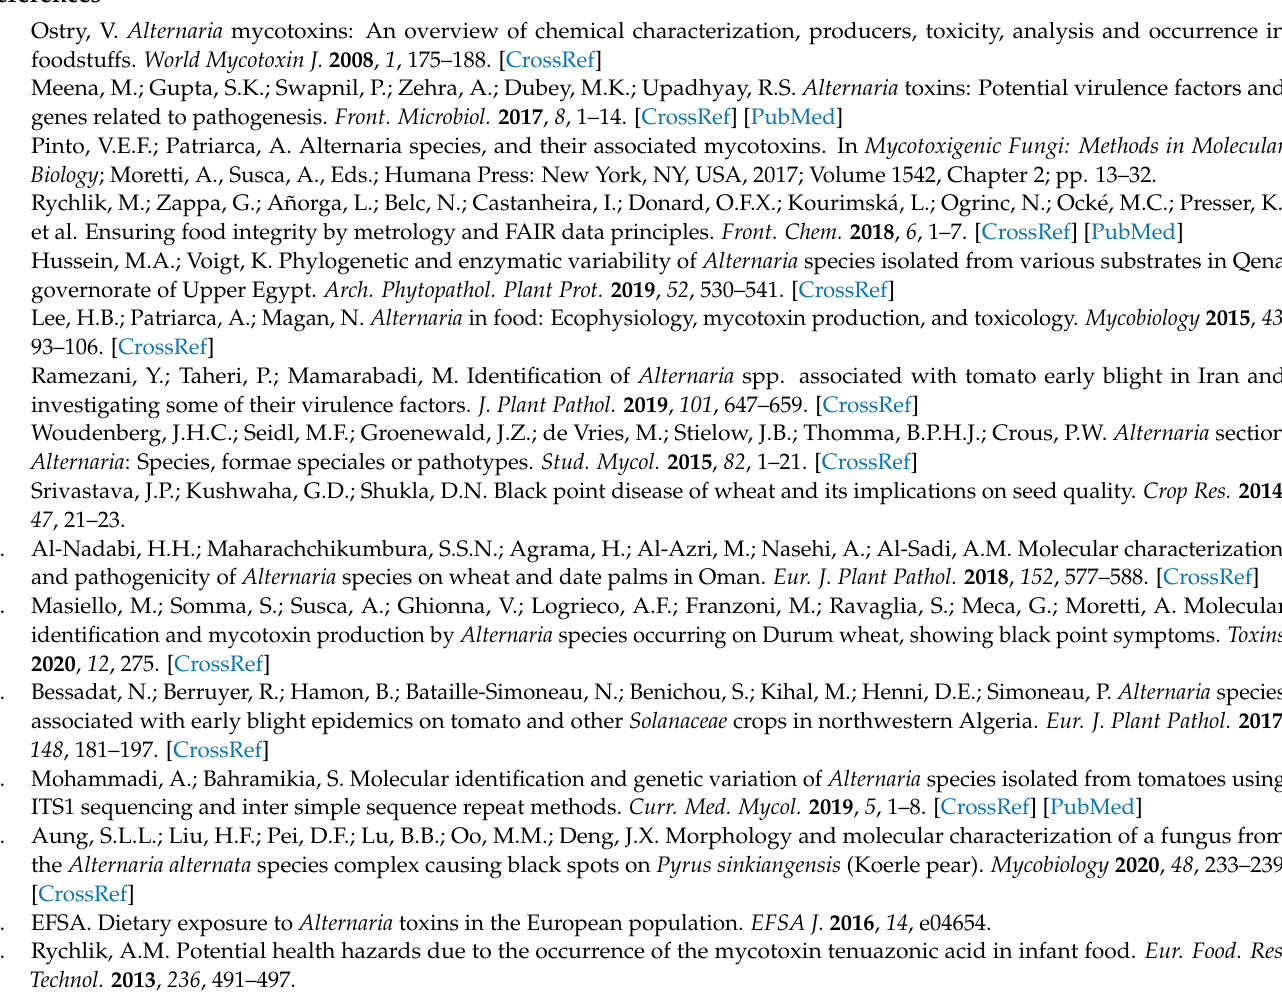
Figure S2: Tomato infected with Alternaria . Table S1: Total counts (calculated per (3 × 4) × 20 pieces), number of cases of isolation (NCI, out of 20), occurrence remarks (OR), and the relative importance value (RIV) of fungal genera and species isolated from tomato